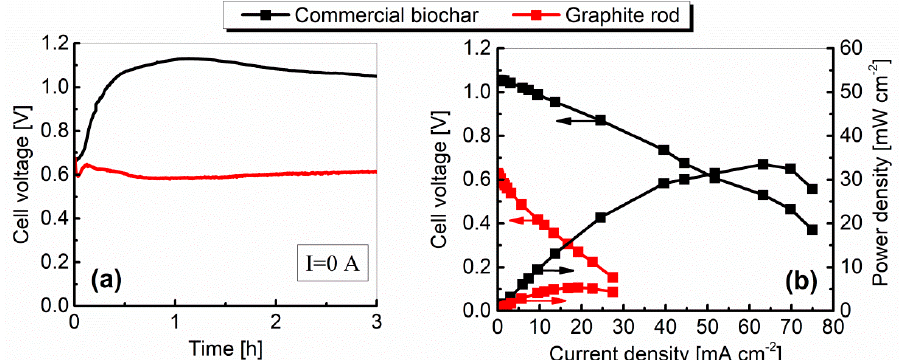
Figure 20. The variation of the fuel cell voltage vs. time ( a ) and performance characteristics ( b ) of the MH-DCFC model III constructed from nickel.